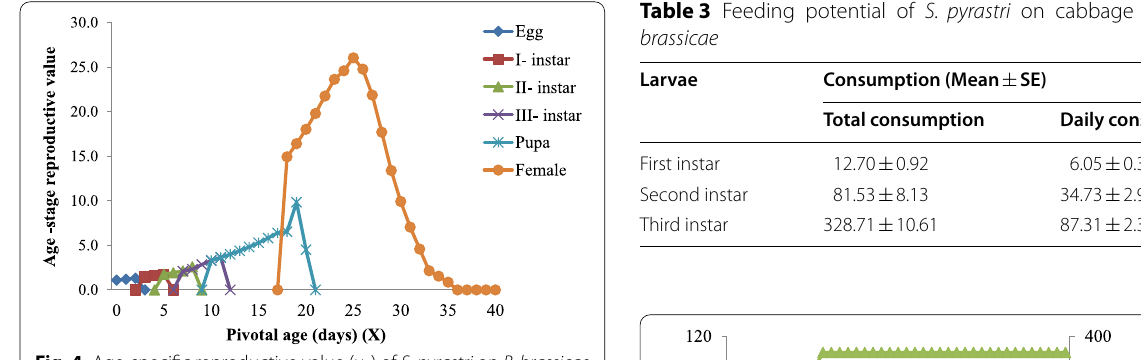
Fig. 4 Age-specific reproductive value ( v xj ) of S. pyrastri on B. brassicae